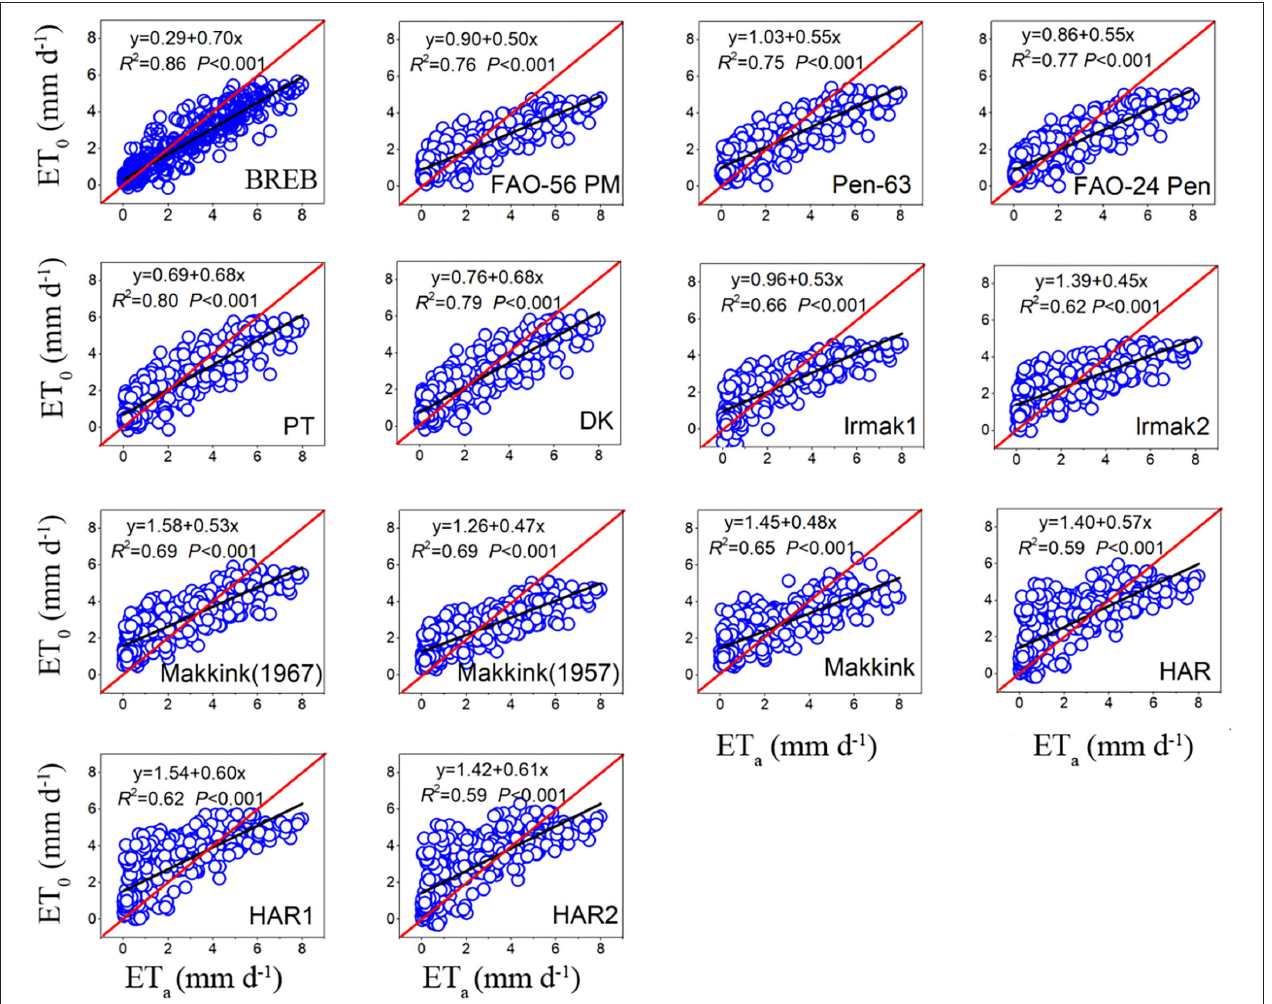
FIGURE 3 | The relationship between daily ET 0 of model estimates and ET a of lysimeter measurements during the whole study period (data points = 393).